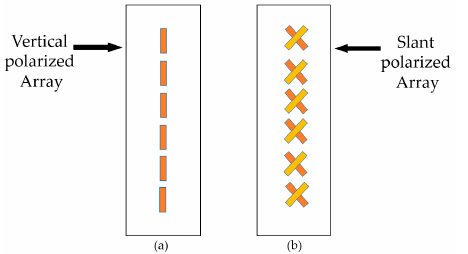
Figure 1. ( a ) Vertical polarized dipole array. ( b ) Slant polarized dipole array.